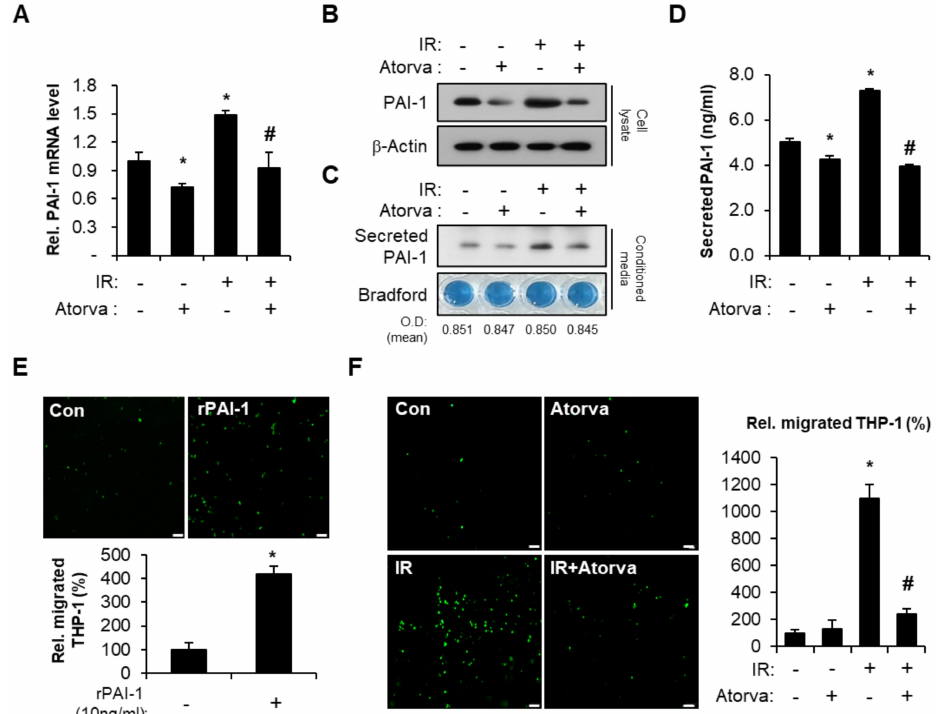
Figure 2. Atorvastatin inhibits PAI-1 production in irradiated endothelial cells and regulates trans-endothelial migration of monocytes. ( A ) mRNA levels and ( B ) protein expression of PAI-1 in control (Con), atorvastatin (Atorva)-treated, irradiated (IR), and IR + Atorva human umbilical vein endothelial cells (HUVECs). ( C ) Western blot analysis and ( D ) Enzyme-linked immunosorbent assay (ELISA) of secreted PAI-1 in conditioned media. The protein content from conditioned media was normalized by Bradford assay. ( E ) Trans-endothelial migration of monocytes in Con and recombinant PAI-1 (rPAI-1)-treated HUVECs. Representative images of migrated CFSE-positive THP-1 cells. The migrated THP-1 cells were counted and plotted. ( F ) Trans-endothelial migration of carbosyfluorescein diacetate succinimidyl ester (CFSE)-stained THP-1 cells co-cultured with Con, Atorva, IR, and IR + Atorva HUVECs. Data are presented as the mean of ± standard deviation of triplicate experiments. Images are representative of 3 independent experiments. * p < 0.05 vs. negative control (Con), # p < 0.05 vs. irradiated control (IR). Scale bars represent 100 µ